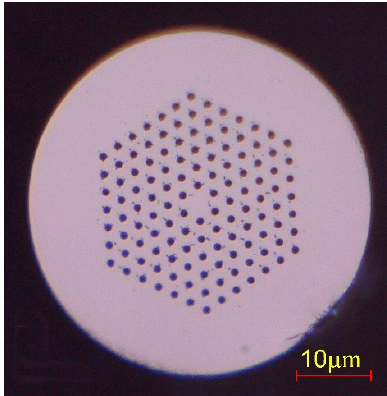
Figure 1. A cross-section of photonic crystal fiber PCF LMA-10 used in our studies.